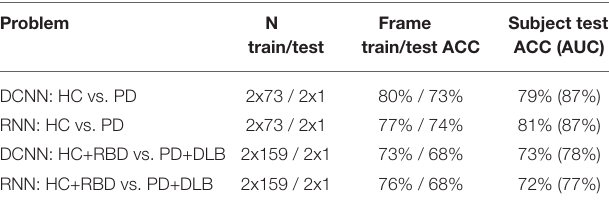
TABLE 1 | Performance in different problems using a single EEG channel (P4, see Figure 4